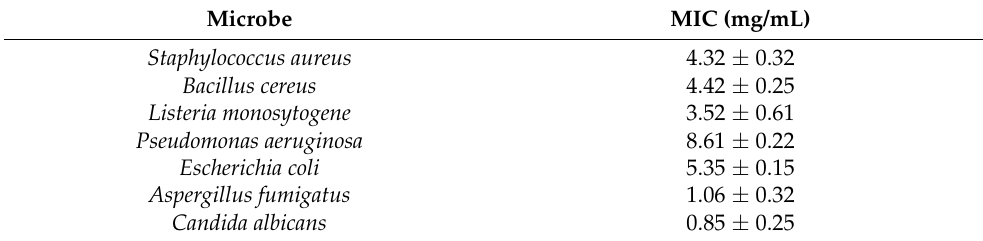
Table 1. Antimicrobial activity (MIC) of